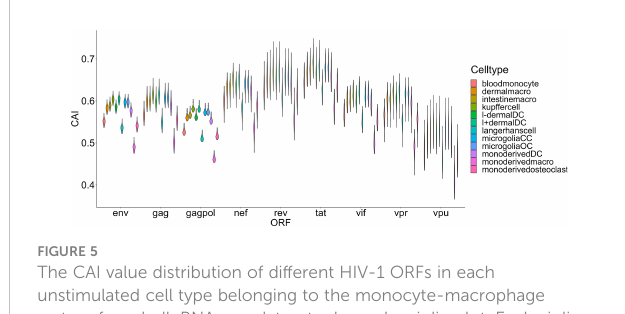
FIGURE 5 The CAI value distribution of different HIV-1 ORFs in each unstimulated cell type belonging to the monocyte-macrophage system from bulk RNA-seq datasets shown by violin plot. Each violin shows the CAI value distribution of a speci fi c HIV-1 ORF in a speci fi c cell type.